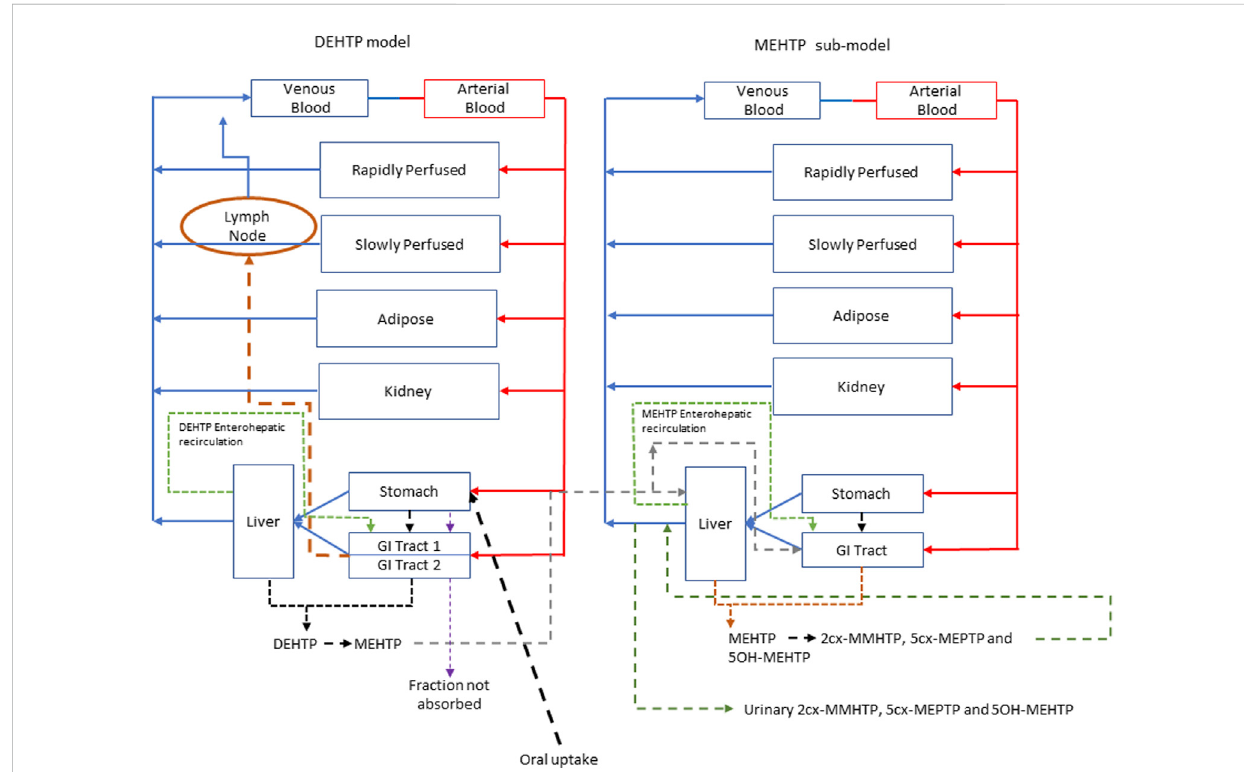
FIGURE 3 A schema of the model for DEHTP and sub-model for MEHTP. The main model contained a lymphatic compartment (- - - -) which received a portionoforaldosefromthestomachandGItract.Urinaryexcretionofmetaboliteswasdescribedwitha fi rst-ordereliminationrateconstantascribedto the sub-model. See Figure 2 for an expanded schematic of the modi fi ed stomach and GI tract